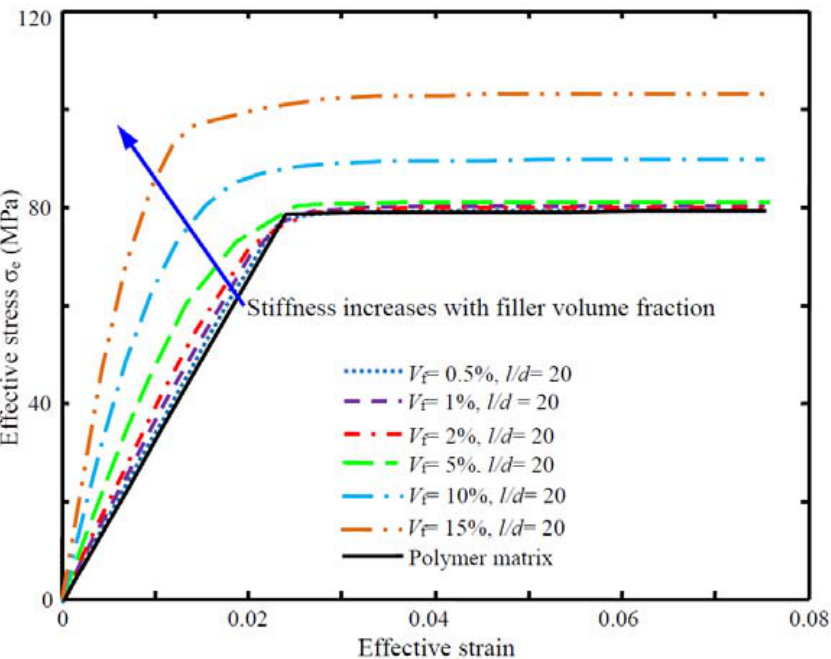
Figure 13. Effective stress-strain diagram σ e - ε e of the PNCs with the clay-particle aspect ratio ρ = 20 (plane-strain; case II).